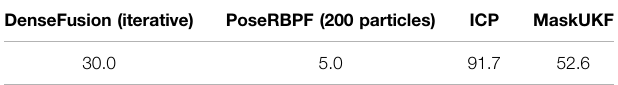
TABLE 6 | Frame rate comparison (fps). Our method is approximately 1.5 × faster than DenseFusion and 10 × faster than